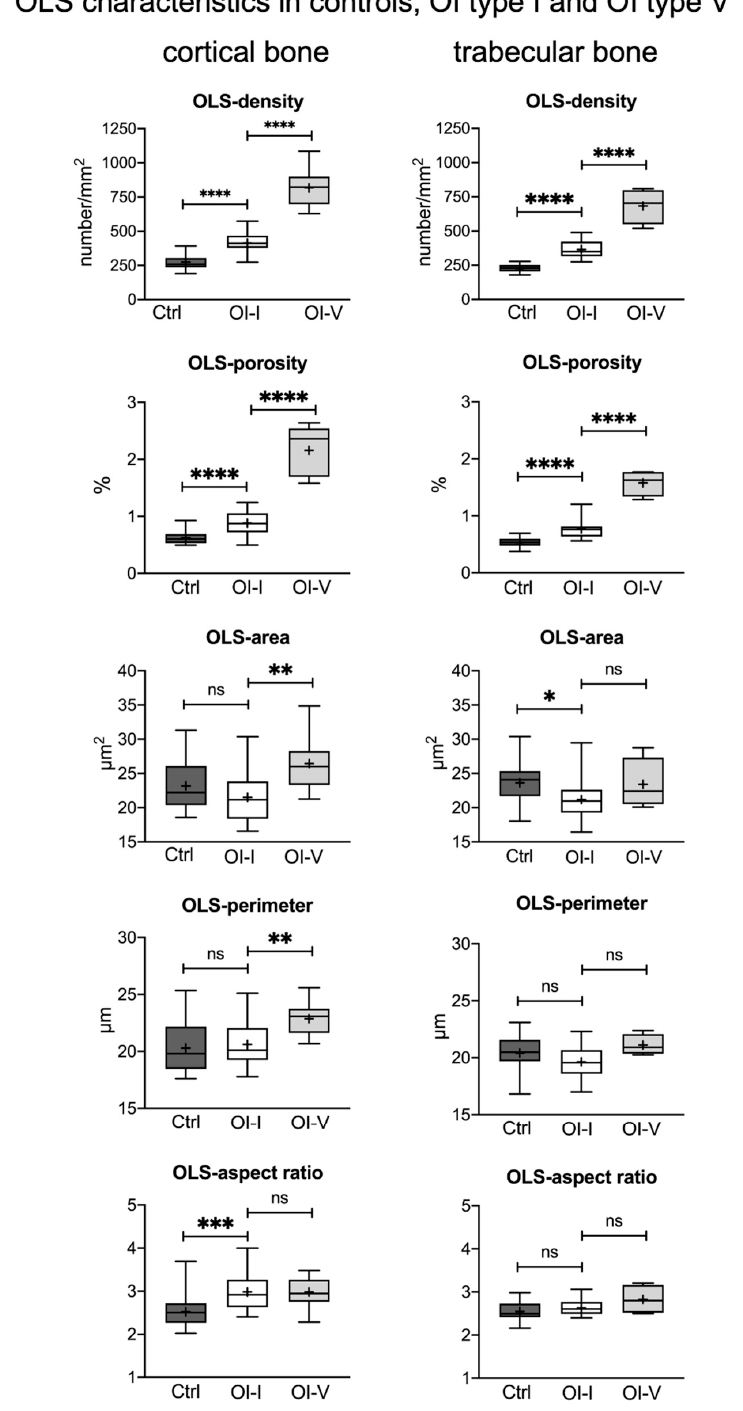
Figure 2. Results of OLS analysis: comparison of OLS characteristics in transiliac bone biopsy samples from children with OI type I ( n = 19) versus controls ( n = 24) and versus OI type V ( n = 15, age: 8.7 ± 4 years-old) previously presented by Blouin et al. [49]. * p < 0.05, ** p < 0.01, *** p < 0.001, **** p < 0.0001; ns = not significant. The left column shows results in trabecular and the right column results in cortical bone. Data are presented using the box-and-whisker plot with the horizontal line in the middle showing median values and the top and bottom lines of the boxes showing the interquartile range. The + inside the boxes represents mean values and the horizontal lines above and below the boxes show maxima and minima.